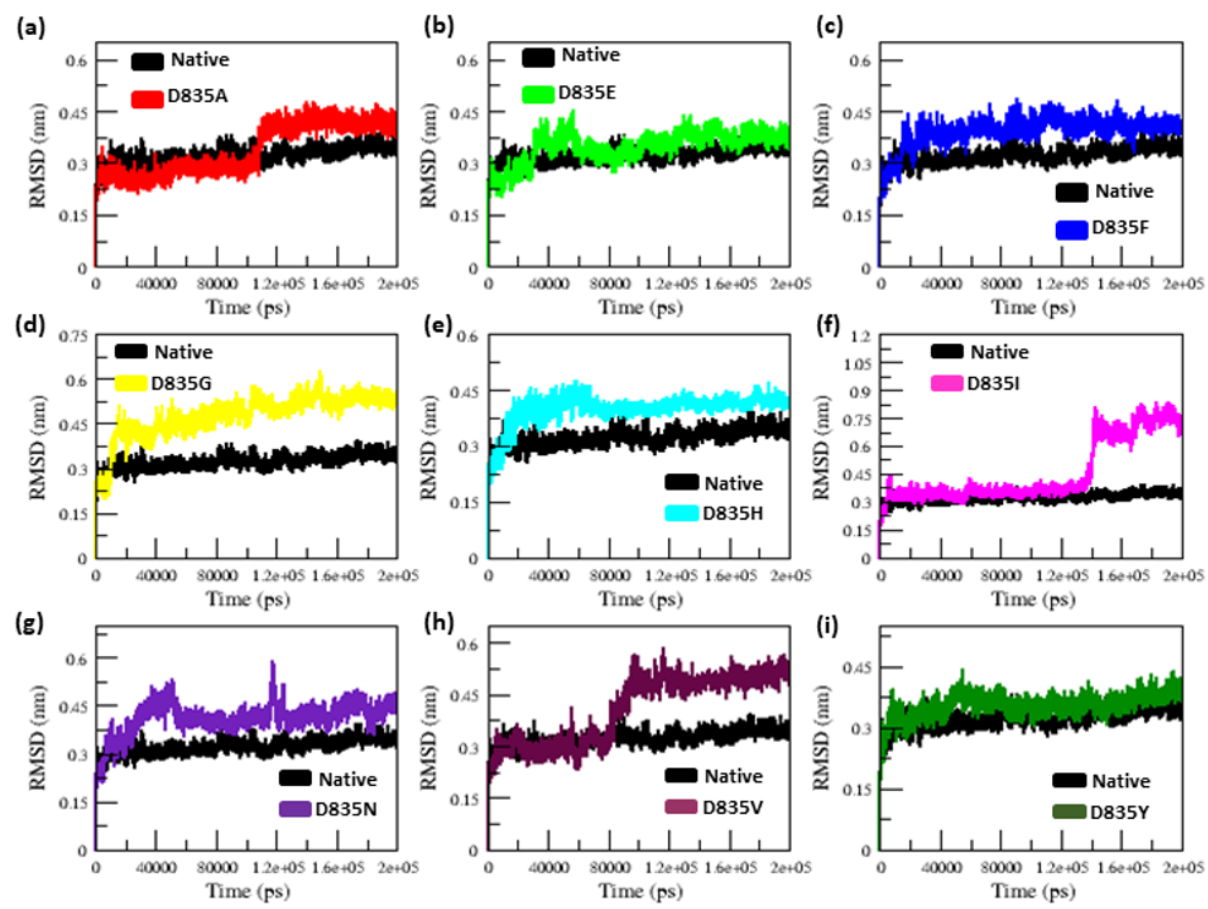
Figure 1. Compared analysis of native and mutants FLT3 backbone RMSD for the period of 200 ns. ( a ) Native vs. D835A; ( b ) Native vs. D835E; ( c ) Native vs. D835F; ( d ) Native vs. D835G; ( e ) Native vs. D835H; ( f ) Native vs. D835I; ( g ) Native vs. D835N; ( h ) Native vs. D835V; ( i ) Native vs. D835Y.